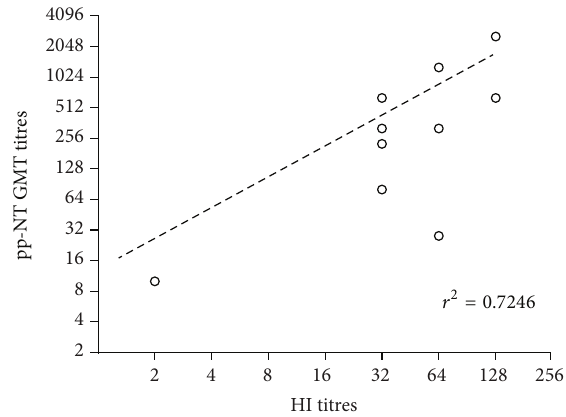
Figure6:Comparisonofpp-NTwithHItiters.Scatterplotsshowing the correlation of antibody logarithmic titers measured by pp- NT (using HPAI H7 A/chicken/Italy/13474/99 pp) versus HI (HI antigen: H7N3 A/ty/Italy/9289/V02). The total number of sera was 51. Graph shows the linear regression fitted to the data using